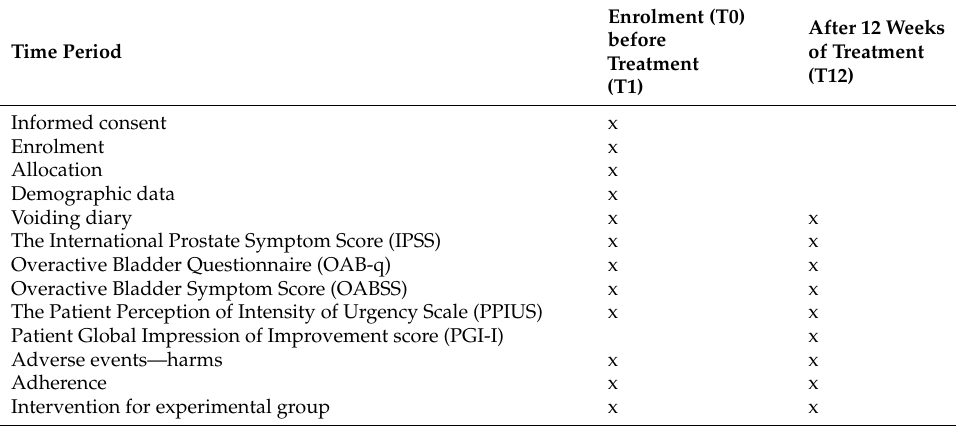
Table 1. Recruitment, intervention, and evaluation plan for the experimental and control groups in the Silodosing